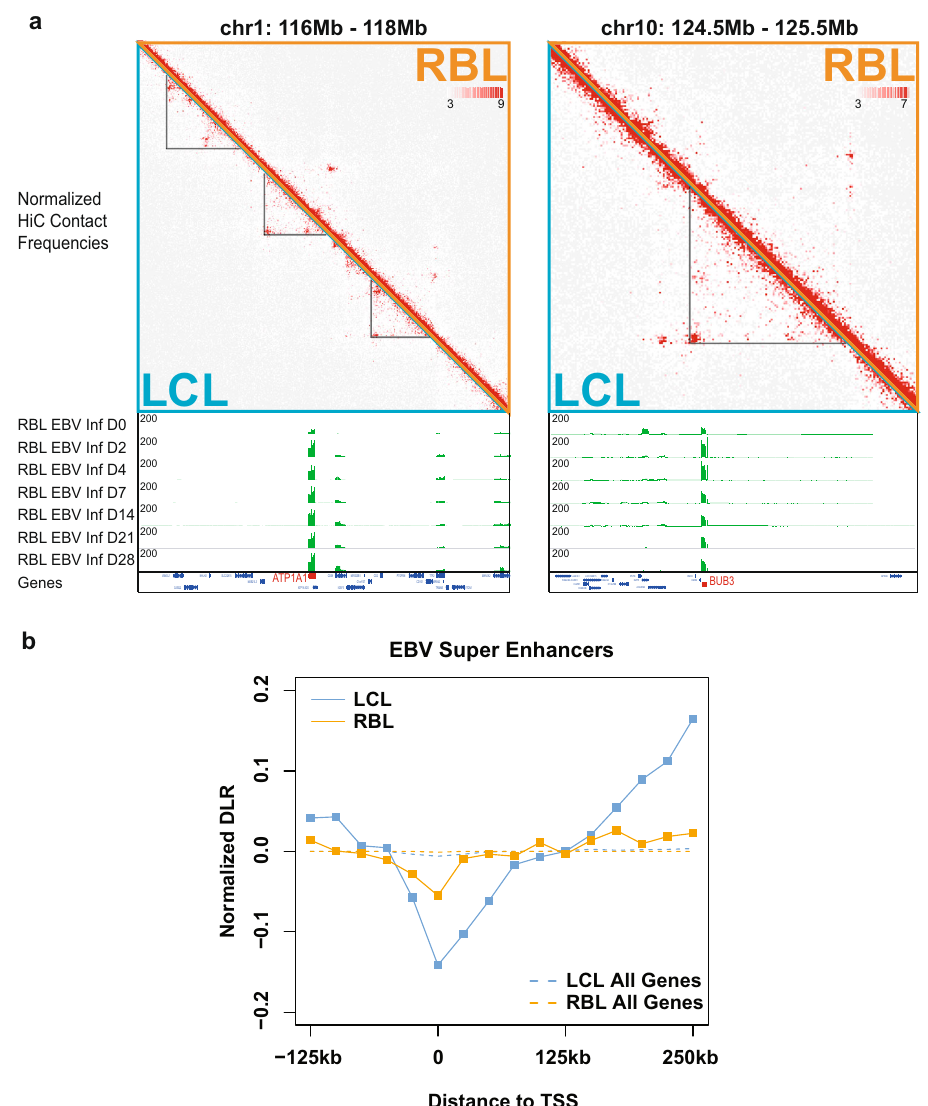
Fig. 3 | Global changes in contact domain at ESEs and their target genes. a Normalized Hi-C contact frequencies for RBLs (orange triangle) and LCLs (teal triangle) at 2 representative loci are shown on top. Left: Chromosome 1, 116Mb to 118Mb. Right: Chromosome 10, 124.5Mb to 125.5Mb. Visible changes in LCL domainsaretracedoutinblack,andRNA-seqtracksforRBLafterEBVinfectionare